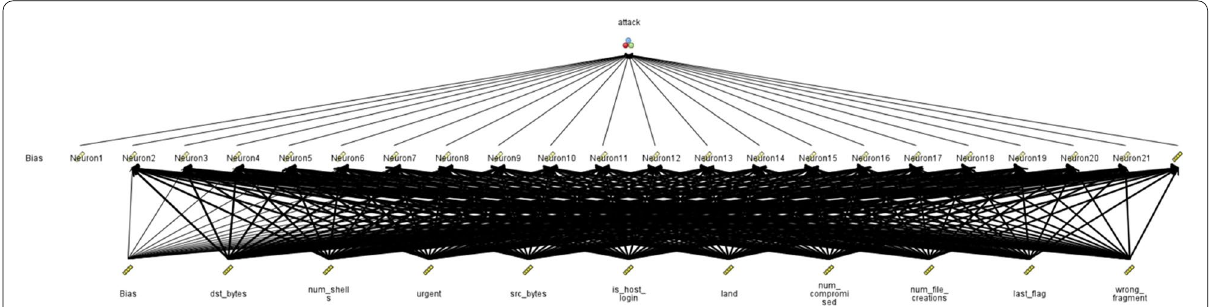
Fig. 4 Neural Network details